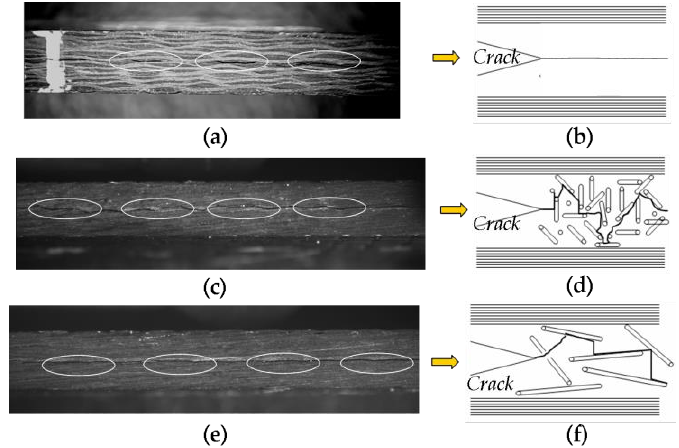
Figure 8. The crack propagation path in the mid-layer of laminates during Mode I DCB tests: ( a,b ) pure; ( c,d ) SCFs (7.8 mg/cm 2 ) and ( e,f ) LCFs (7.8 mg/cm 2 ).